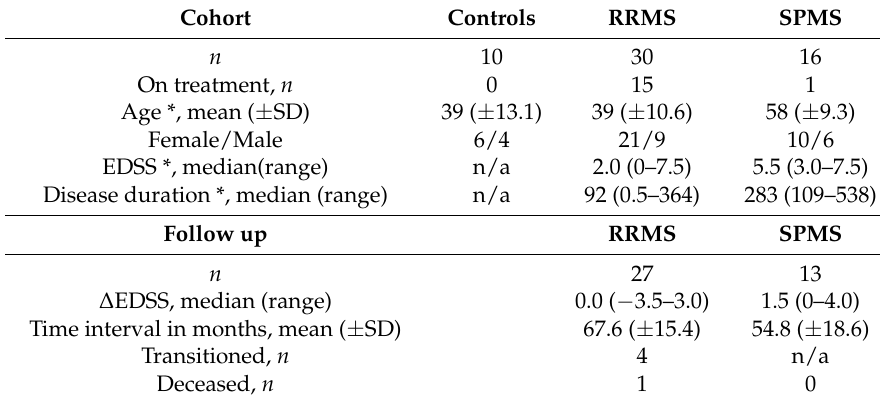
Table 1. Clinical and demographic data including follow-up data on the patients. Four of the RRMS patients had transitioned to SPMS, one of whom was deceased.